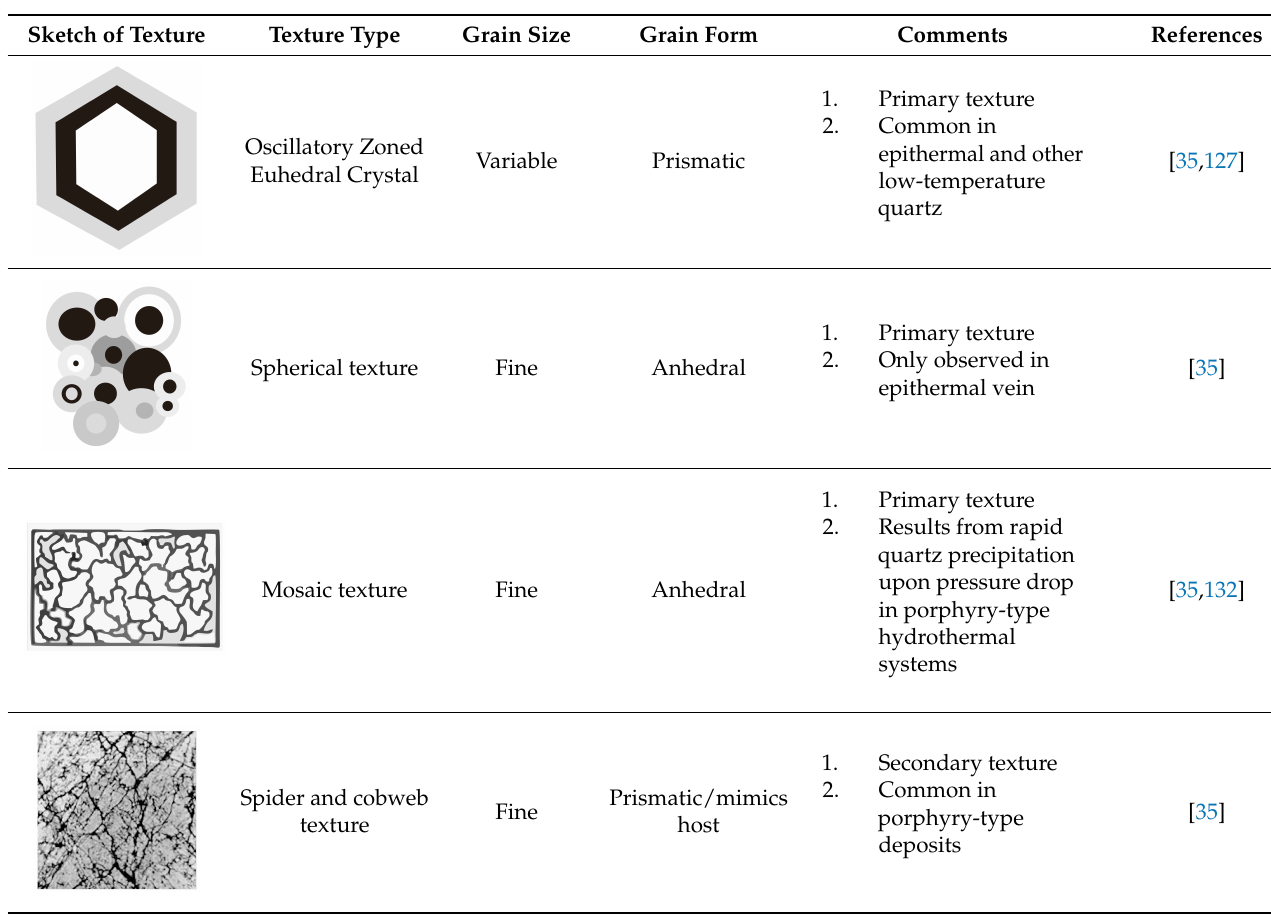
Table 2. Some typical hydrothermal quartz textures with their